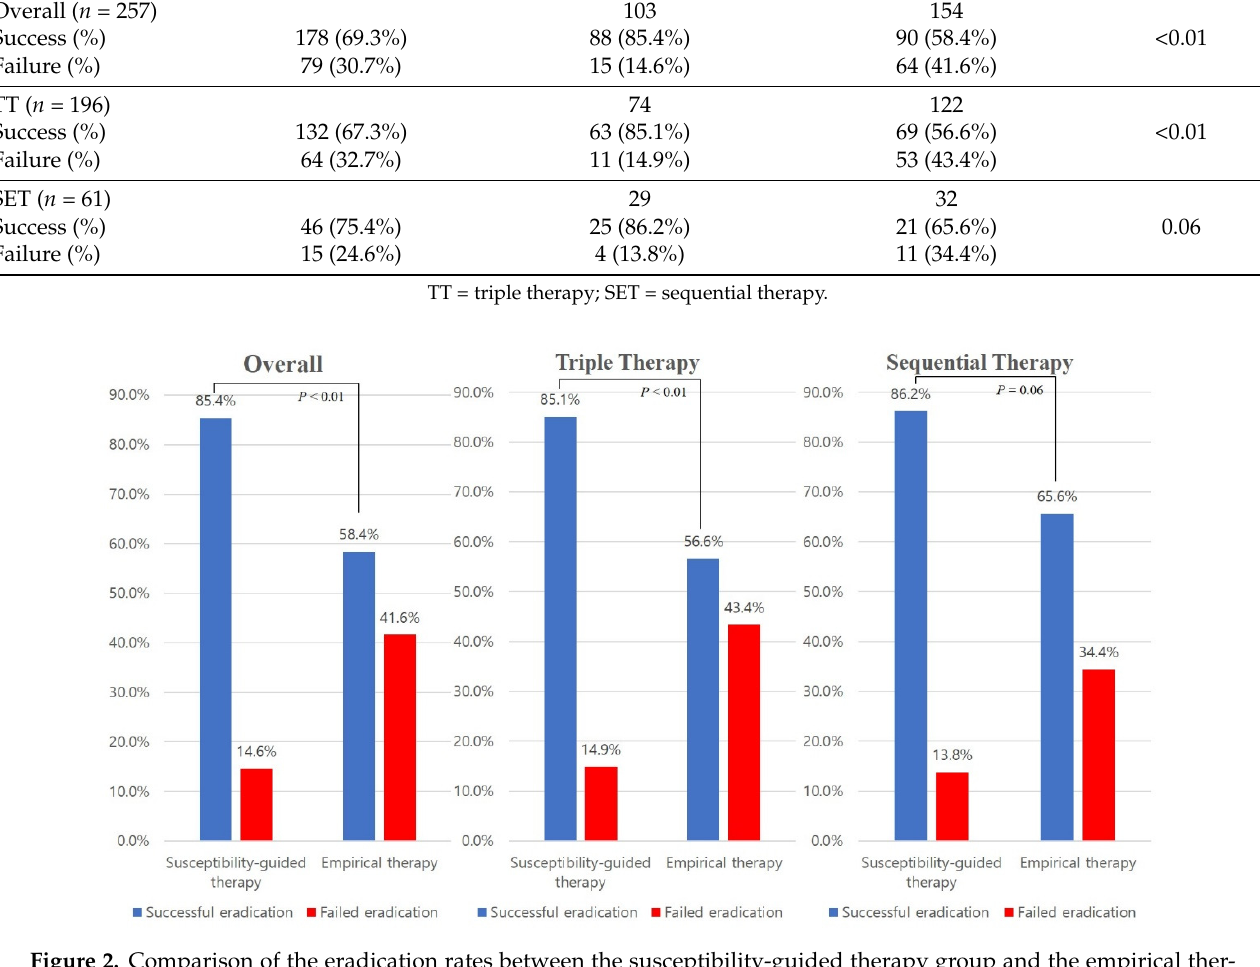
Figure 2. Comparison of the eradication rates between the susceptibility-guided therapy group and the empirical therapy group.